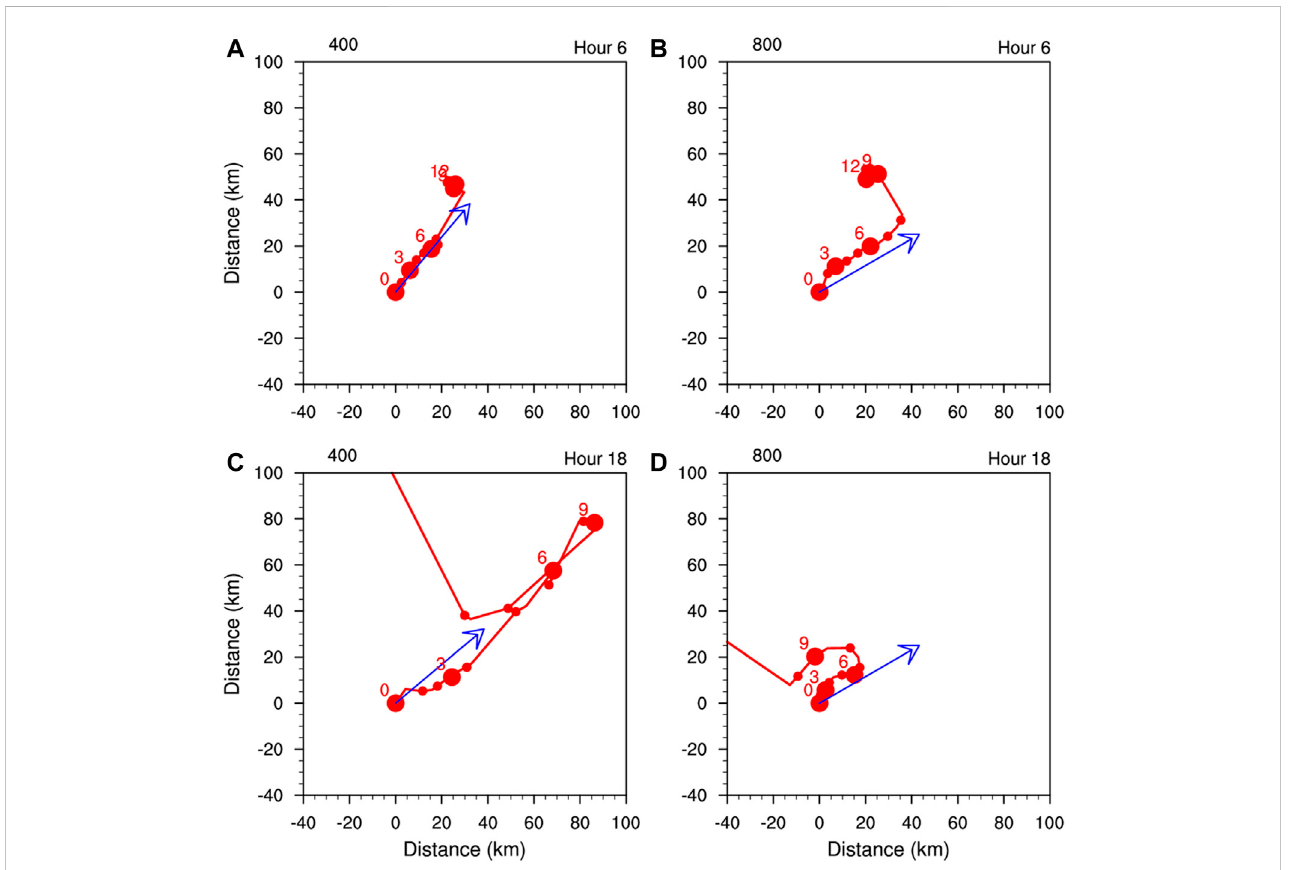
FIGURE 10 Hodographsofthevortexcentersatdifferentheights(km); (A,C) showdatafromEXP400and (B,D) showdatafromEXP800; (A,B) areathour6and (C,D) are at hour 18. Small dots are plotted every 1 km, and large dots are plotted every 3 km. Numbers indicate the height (km) of the vortex center. The titling direction is indicated by the blue